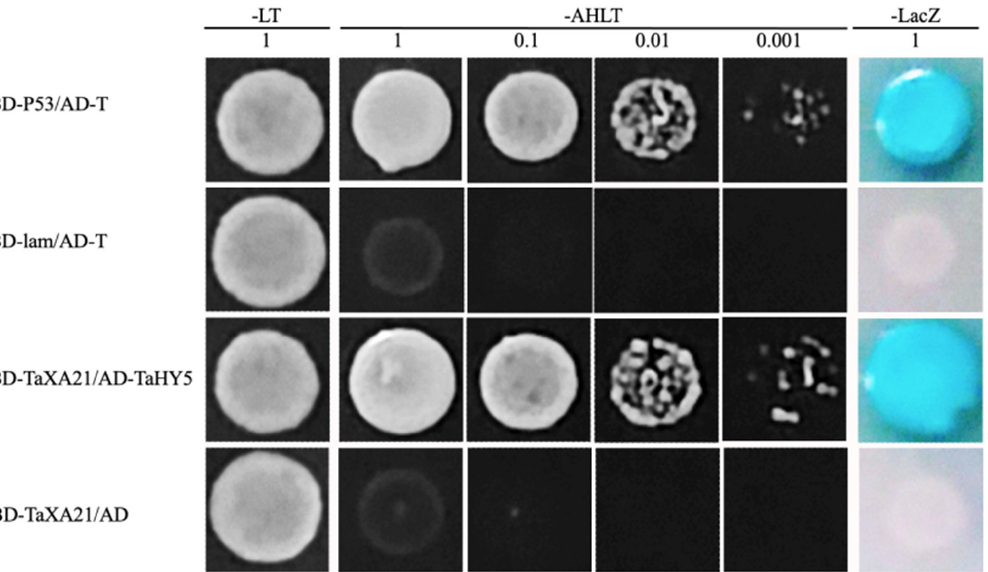
Figure 10. The validated interaction between TaHY5 (encoded by Triticum aestivum newGene 7669 ) and TaXa21 (encoded by TraesCS1A02G009500 ).